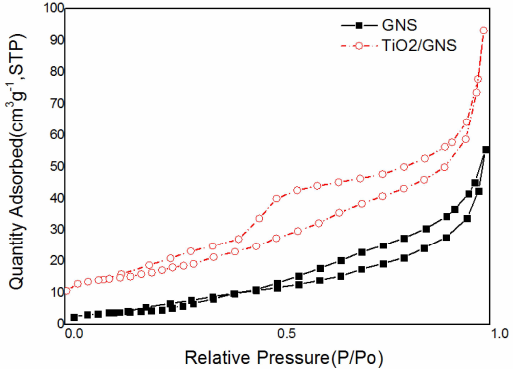
Figure 4. Nitrogen adsorption-desorption isotherms for GNs, TiO 2 /GNs.